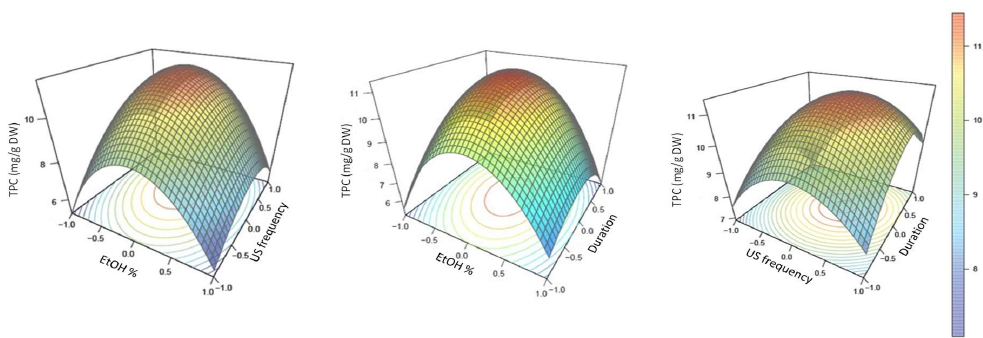
Figure 2. Predicted surface response plots of the TPC extraction yield (in mg/g DW) as a function of aqEtOH concentration and US frequency, aqEtOH concentration and extraction duration, as well as US frequency and extraction duration.